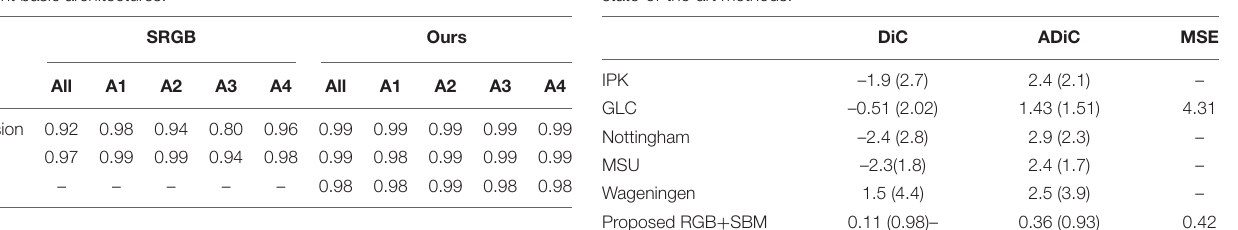
TABLE 5 | Comparative evaluation of the proposed counting model with state-of-the-art methods.